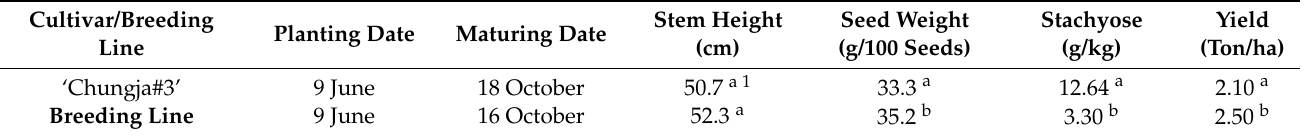
Table 4. Agronomic performance of cultivar ‘Chungja#3’ and the breeding line under field conditions during 2020. Cultivar/Breeding Line Planting Date